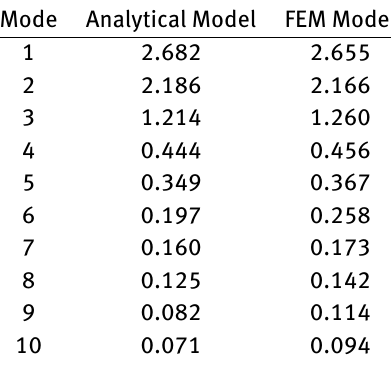
Figure 5: Normalized eigenvector components of the 2nd mode shape